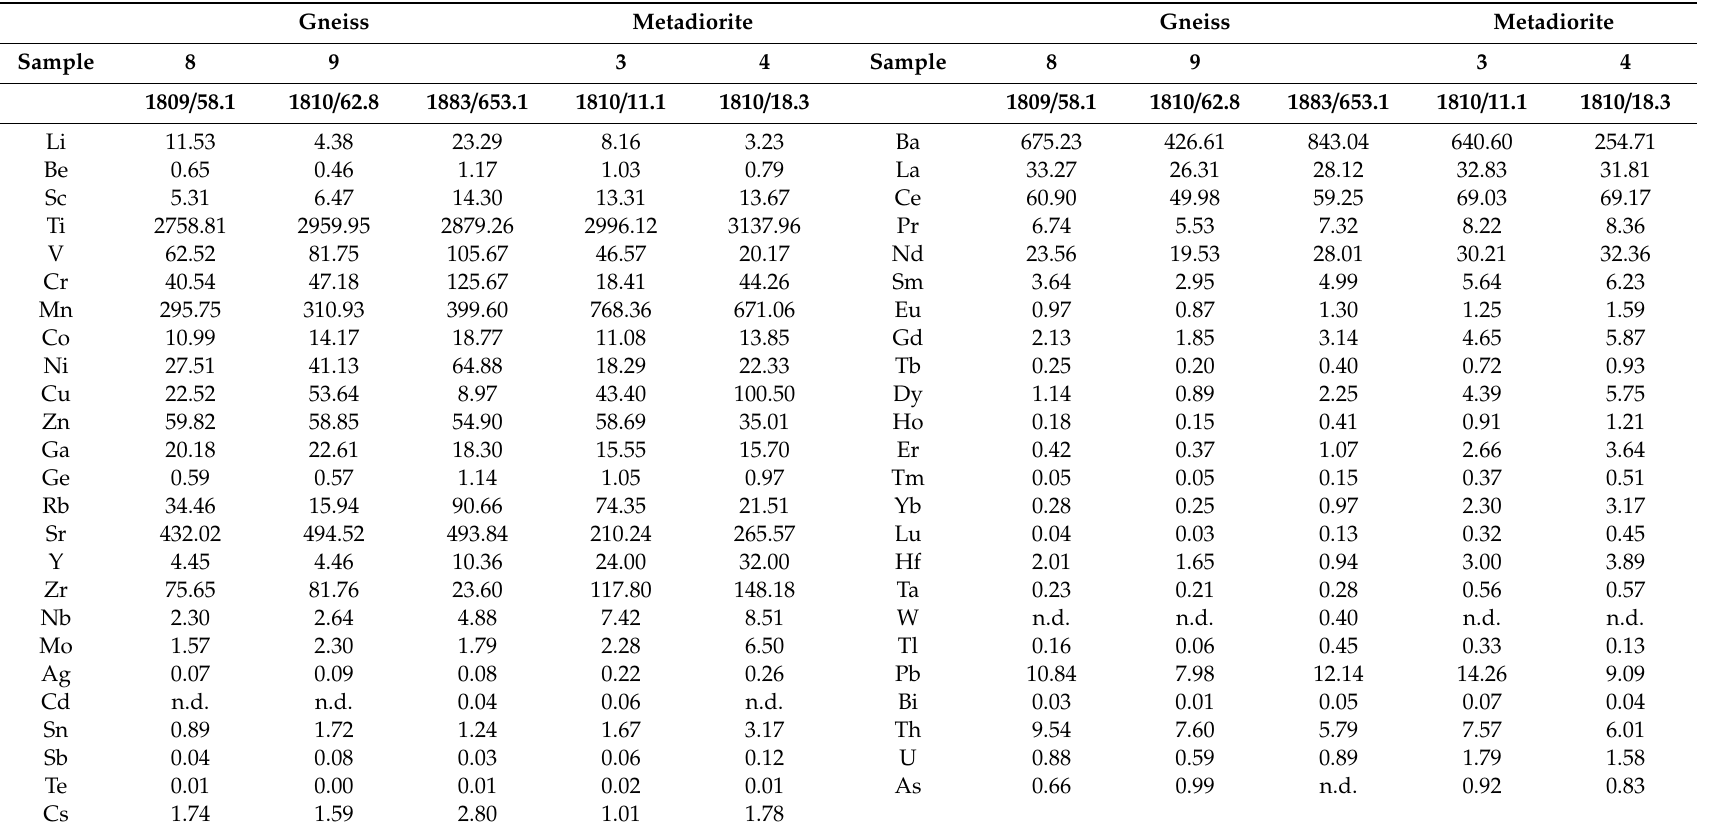
Table 5. Element concentration (ppm) in DW gneiss and metadiorite of the Gabbro-10 massif and borehole 1883. Gneiss Metadiorite